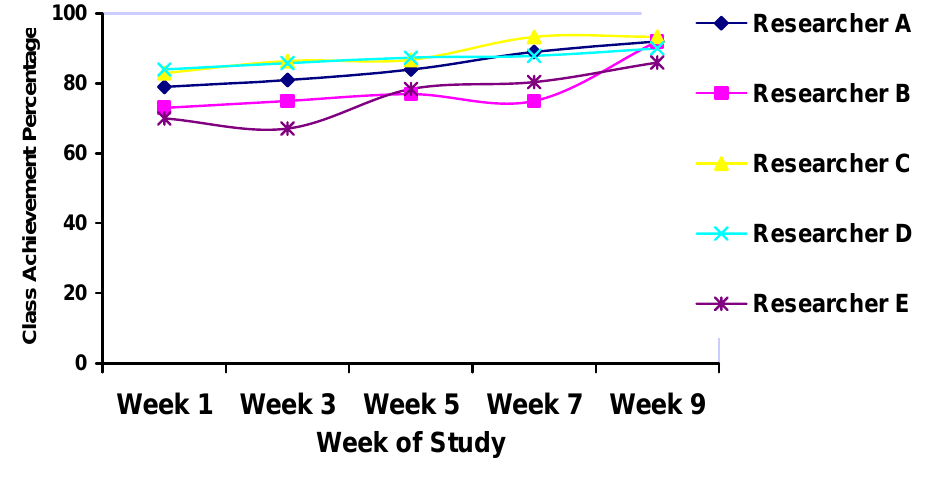
Figure 14. Class Achievement Records compiled during the implementation of posting and communicating daily learning